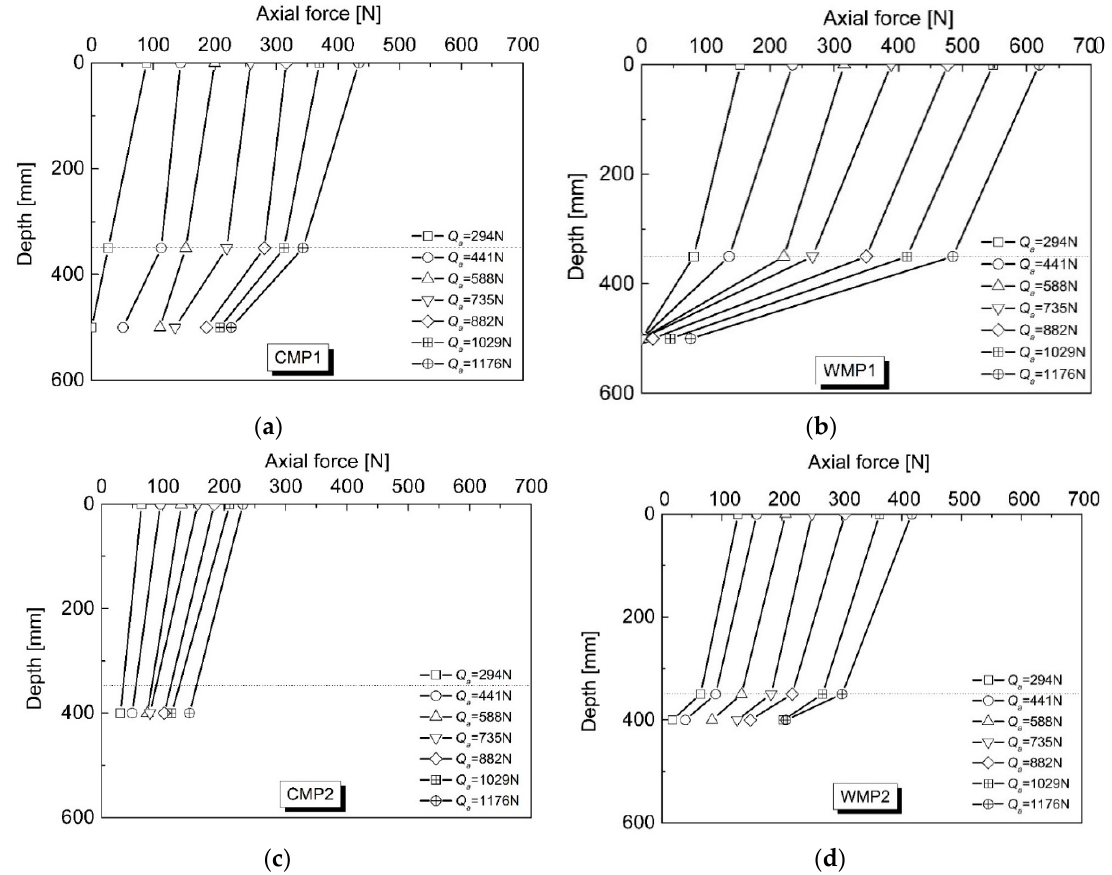
Figure 7. Relation between the reduction of foundation settlement by the underpinned foundation and the normalized stiffness of the existing foundation.